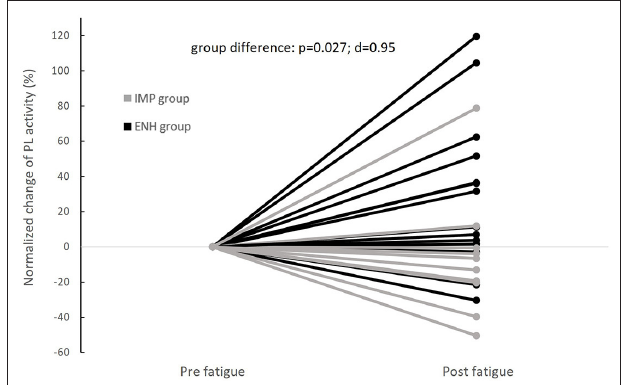
FIGURE 4 | Individual evolutions of normalized change in Peroneus Longus (PL) activity with fatigue between groups (IMP, impaired-stability group; ENH, enhanced-stability group).